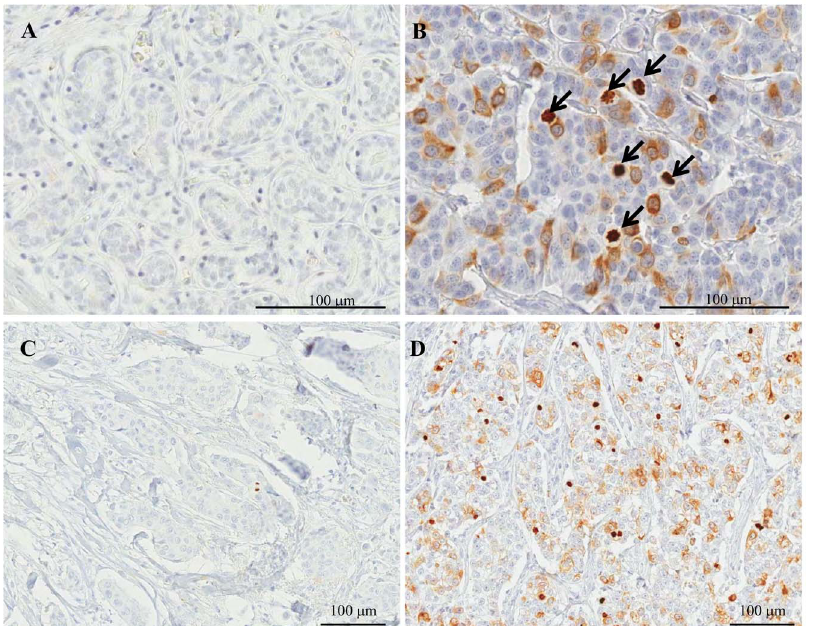
Figure 1. CKAP2 immunohistochemical staining in breast cancer tissues. CKAP2-positive cells are rare in normal breast ductal cells (A), but present variably in breast cancer tissues (B). The chromatin CKAP2-positive cell numbers were variable: low as in (C), or high as in (D). One hundred m l rulers are shown. The arrows indicate chromatin CKAP2 staining. doi:10.1371/journal.pone.0098160.g001 PLOS ONE |